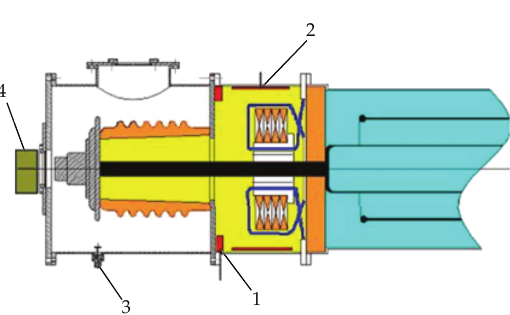
Figure 1: Diagnostic equipment of the pulsed electron accelerator: (cid:2) 1 (cid:3) Rogowski coil, (cid:2) 2 (cid:3) capacitive voltage divider, (cid:2) 3 (cid:3) di ff erential voltage divider, and (cid:2) 4 (cid:3) Faraday cup.